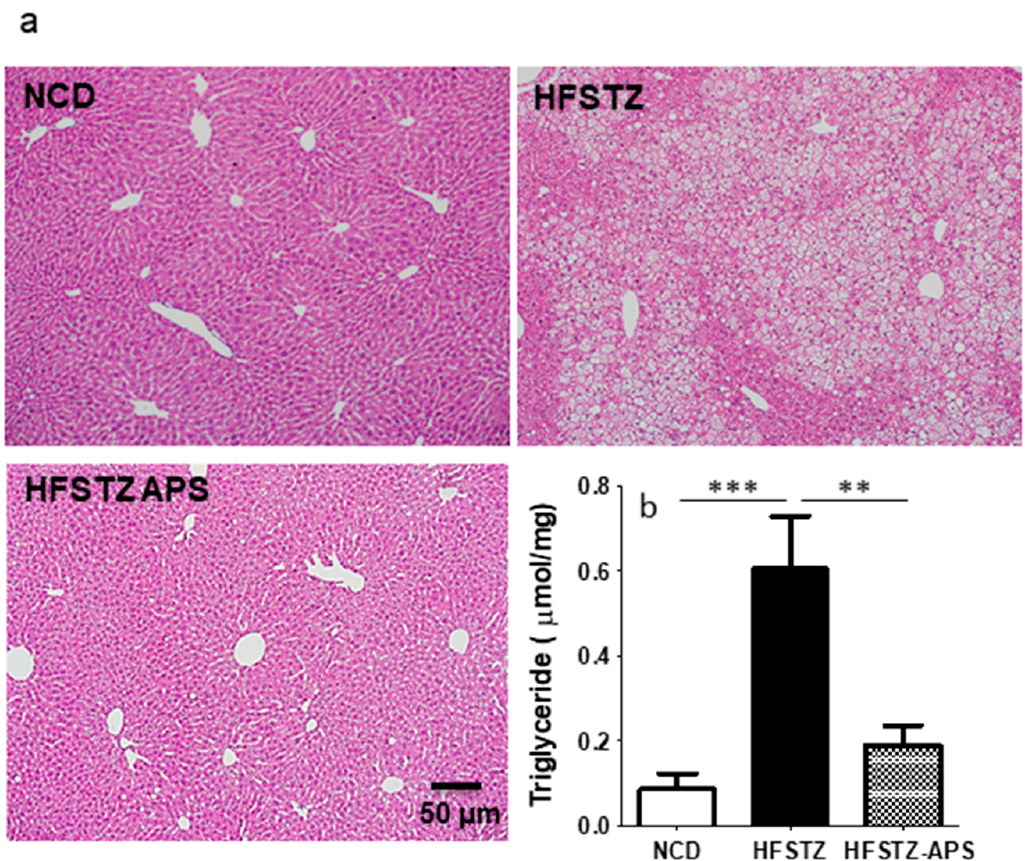
Figure 4. APS ameliorated HFSTZ-induced hepatic steatosis. Three groups of APP/PS1 mice: NCD ( n = 6), HFSTZ ( n = 5) or HFSTZ-APS ( n = 7) are examined. ( a ) Representative images of HE-stained liver sections (scale bar, 50 μ m) were shown. ( b ) Hepatic triacyl glycerol (TG) contents were quantified. Bars represent the mean ± SEM. ** p < 0.01 and *** p < 0.001, significant difference from HFSTZ group.